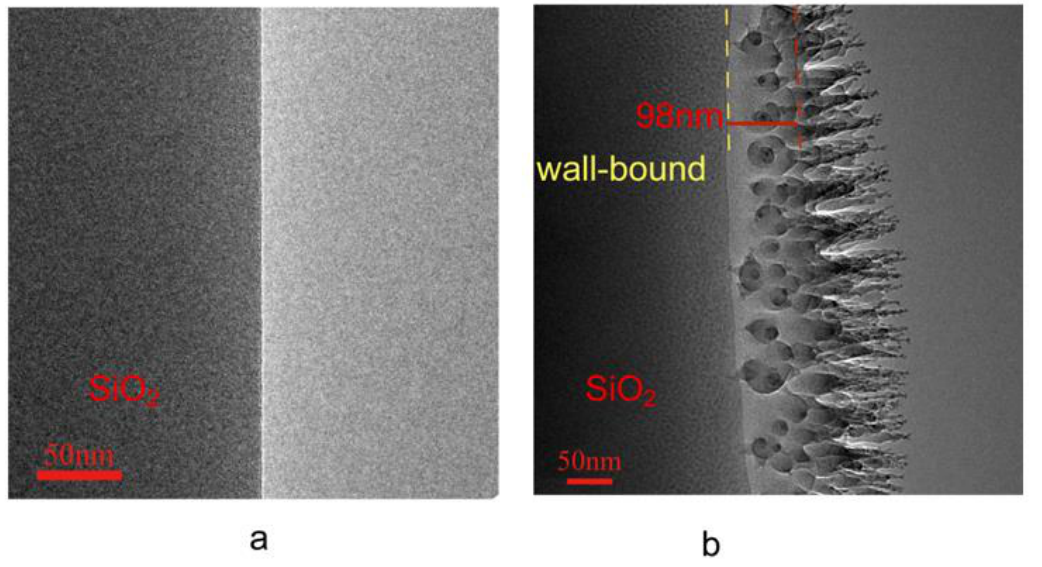
Figure 2. Sectional TEM image of sliced samples in silica microtubules 5 µ m in ID before and after soaking in hexadecane. ( a ) is the TEM image before soaking in hexadecane. ( b ) is the TEM image after soaking in